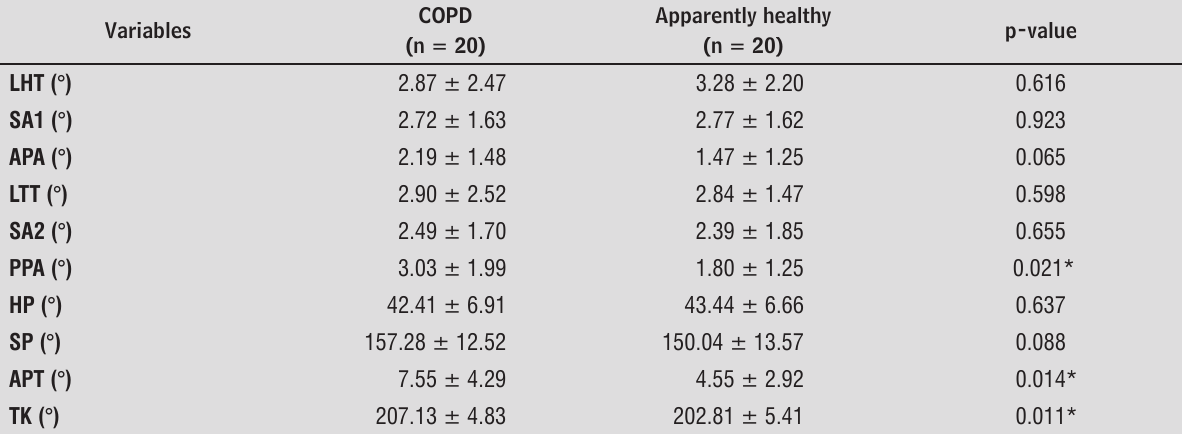
Table 2 – Comparison between the postural alignment of COPD patients and apparently healthy individuals (n = 40) Variables